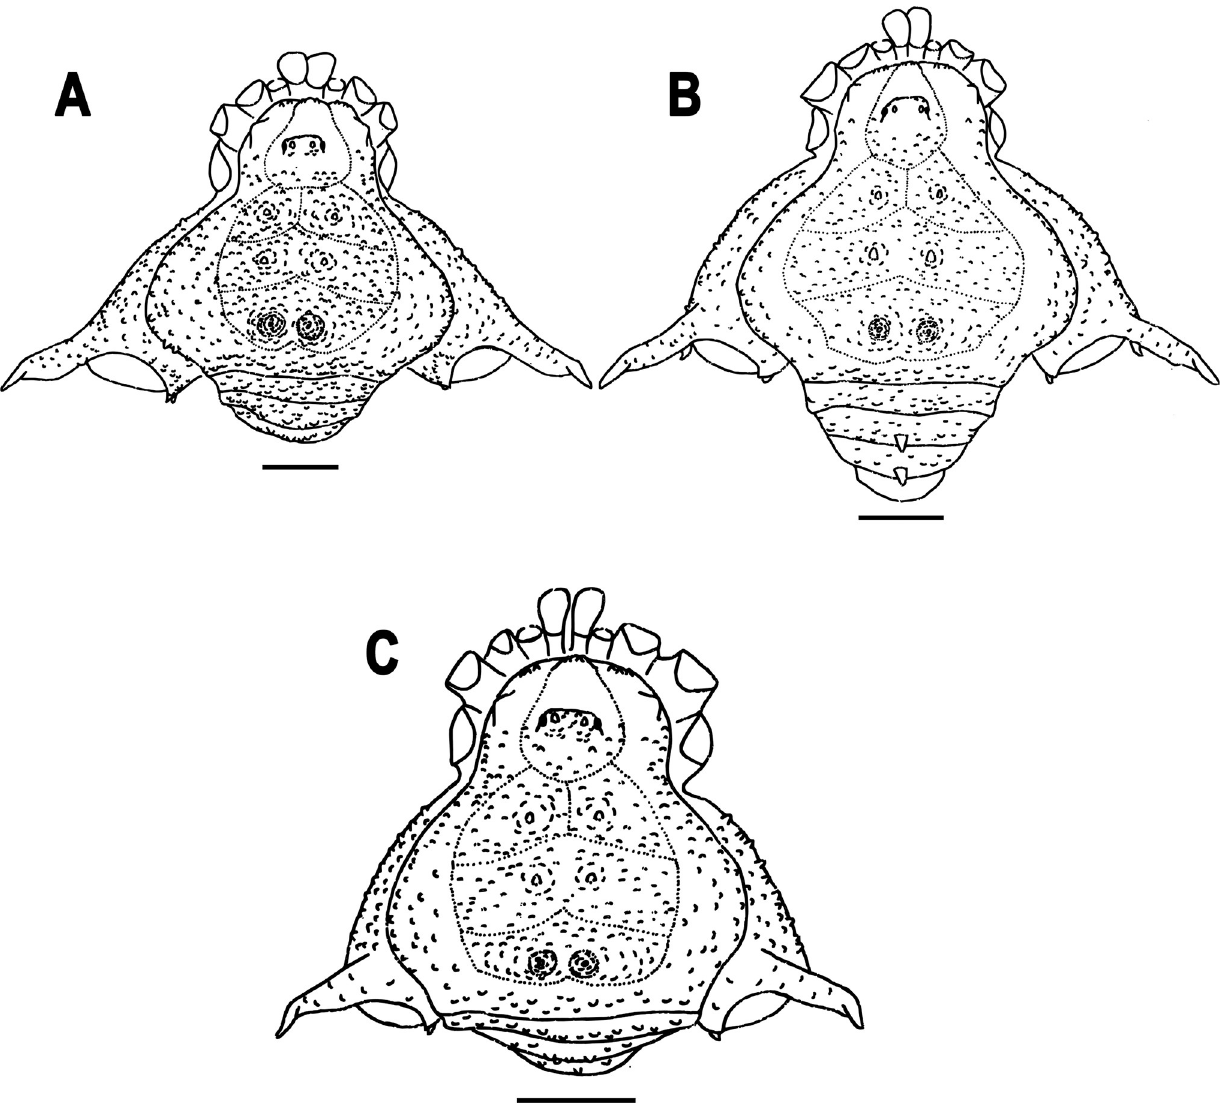
Fig 3. Illustrations of the dorsal habitus of Neosadocus males, with dorsal scutum, free tergites, segments I–II of chelicerae, and coxae of pedipalps and legs I–IV. A. N . bufo . B. N . robustus . C. N . maximus . Scale bars: 3 mm.